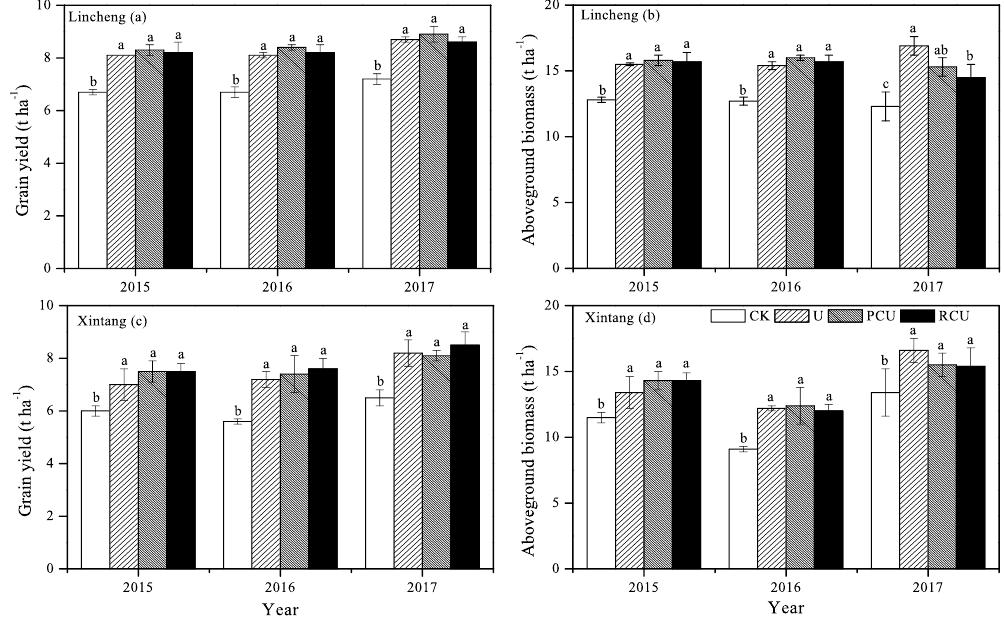
Figure 2. The grain yield and aboveground biomass of rice were affected by the different treatments at the two experimental sites during the 2015 to 2017 rice growing season. The values are presented as the mean ± standard deviation (n = 3). The different letters represent significant differences at the level of P < 0.05. CK, U, RCU and PCU represent no N application, conventional urea, resin-coated urea and polyurethane-coated urea, respectively.